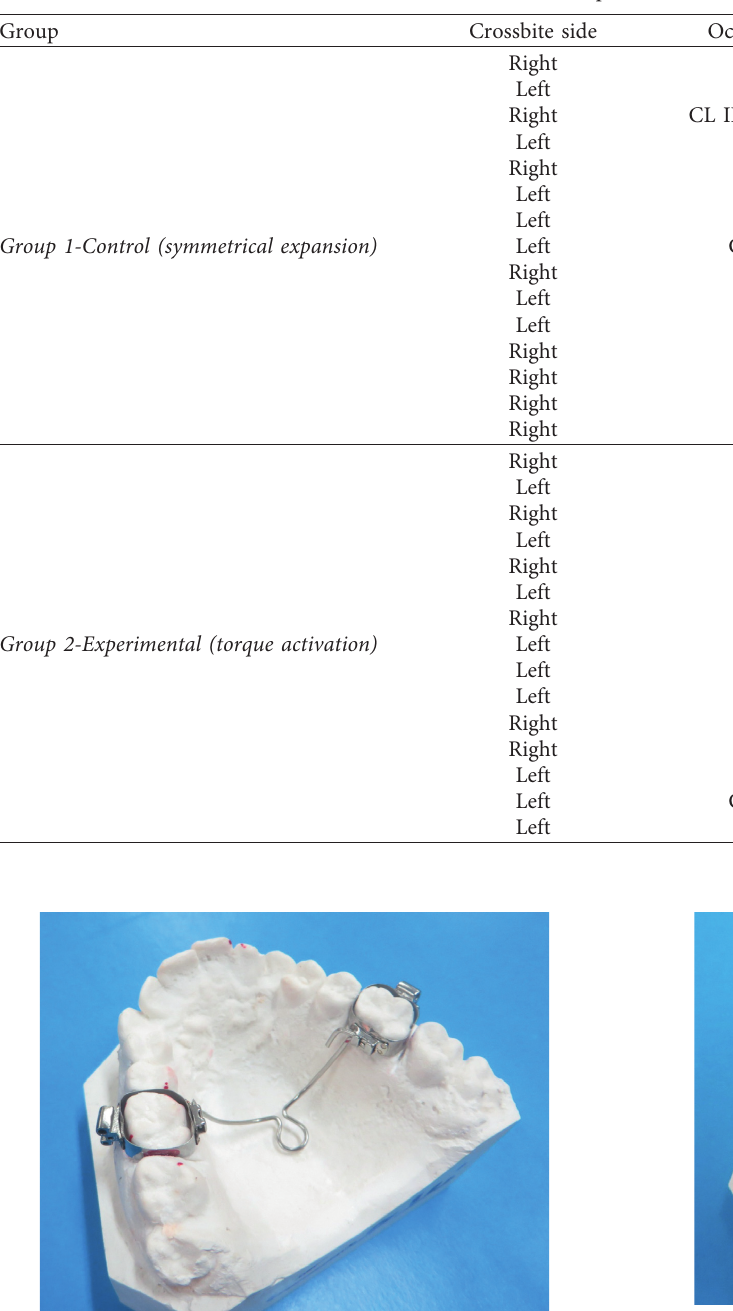
Table 1: Sample characteristics.